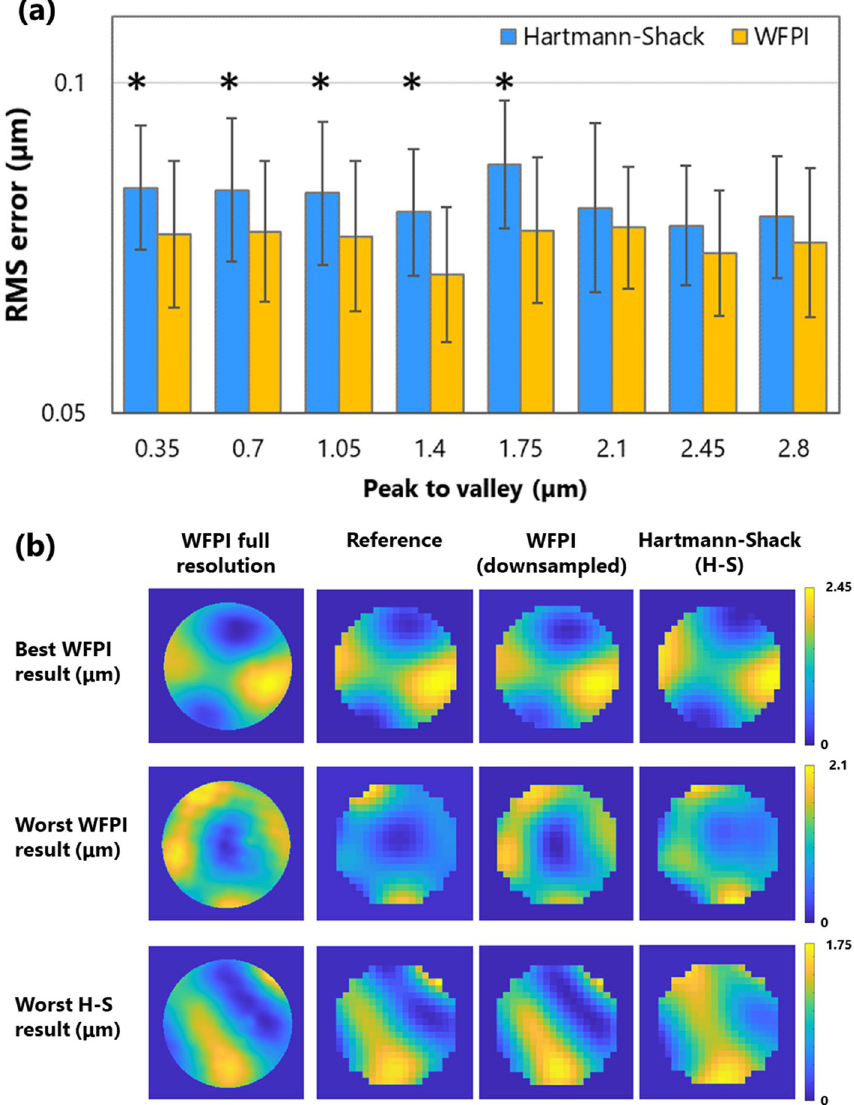
Figure 4. Instrument validation results using the WFPI sensor, a deformable mirror (DM), and a Hartmann- Shack sensor (H–S). (a) For a variety of different amplitudes or peak-to-valley values, the average root-mean- square (RMS) errors of the residual phase map calculated by subtracting the measured phase maps from the reference maps and the error bars corresponding to the standard deviation are shown. An asterisk, *, indicates a statistically significant difference between the two sensors (p-value < 0.05). (b) The first row shows the case in which the WFPI sensor yielded its best result, the second row shows the case in which the WFPI sensor yielded its worst result, and the third row shows the case in which the H–S sensor yielded its worst result. The first column shows the high-resolution result of the WFPI sensor. The data are for a 4 mm pupil